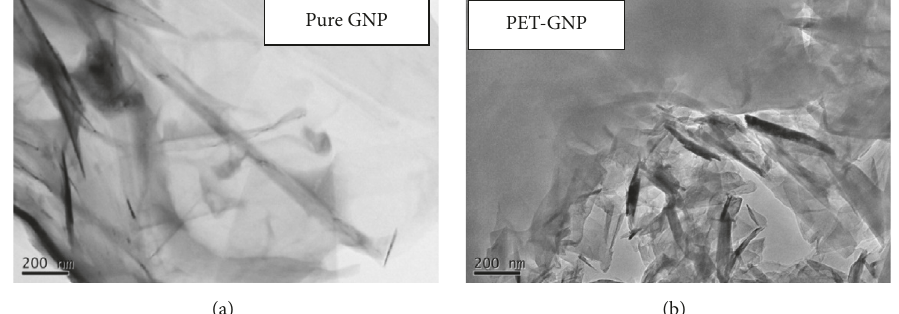
Figure 8: TEM images of as-received GNP (a) and a PET-GNP nanocomposite containing 6wt.% of GNP